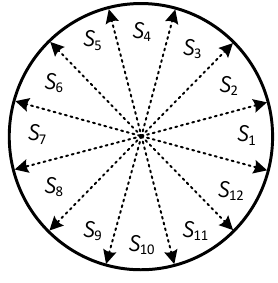
Figure 9. Sector division. Figure 9. Sector